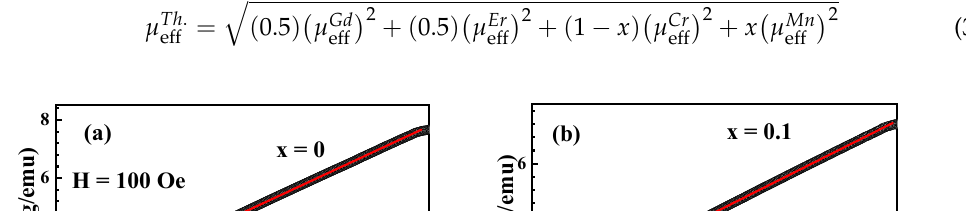
where N is the Avogadro number and k B is the Boltzmann constant. The theoretical effective magnetic moment value was also estimated using the free ionic moments of Gd 3+ (7.9 µ B ), Er 3+ (9.59 µ B ), Cr 3+ (3.87 µ B ) and Mn 3+ (4.90 µ B ) by the following equation: